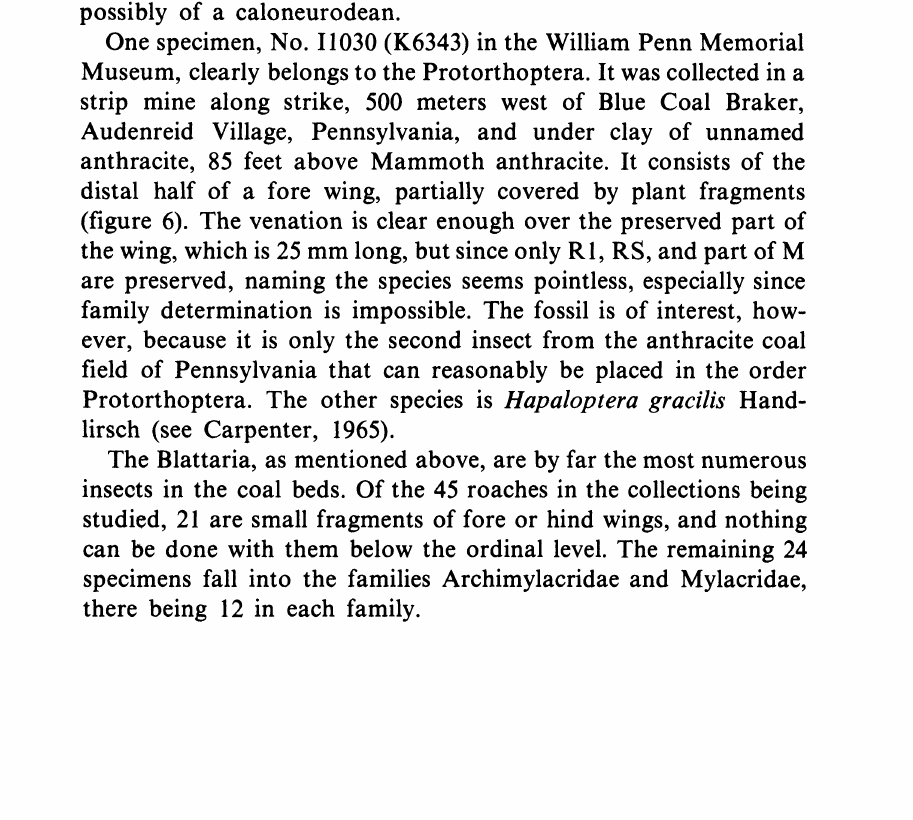
Figure 4. Drawing of specimen no. 11035 (K6339), order uncertain, from Upper Carboniferous of Pennsylvania, near Trenton. Length of wing fragment, 13 mm. Lettering as in figure